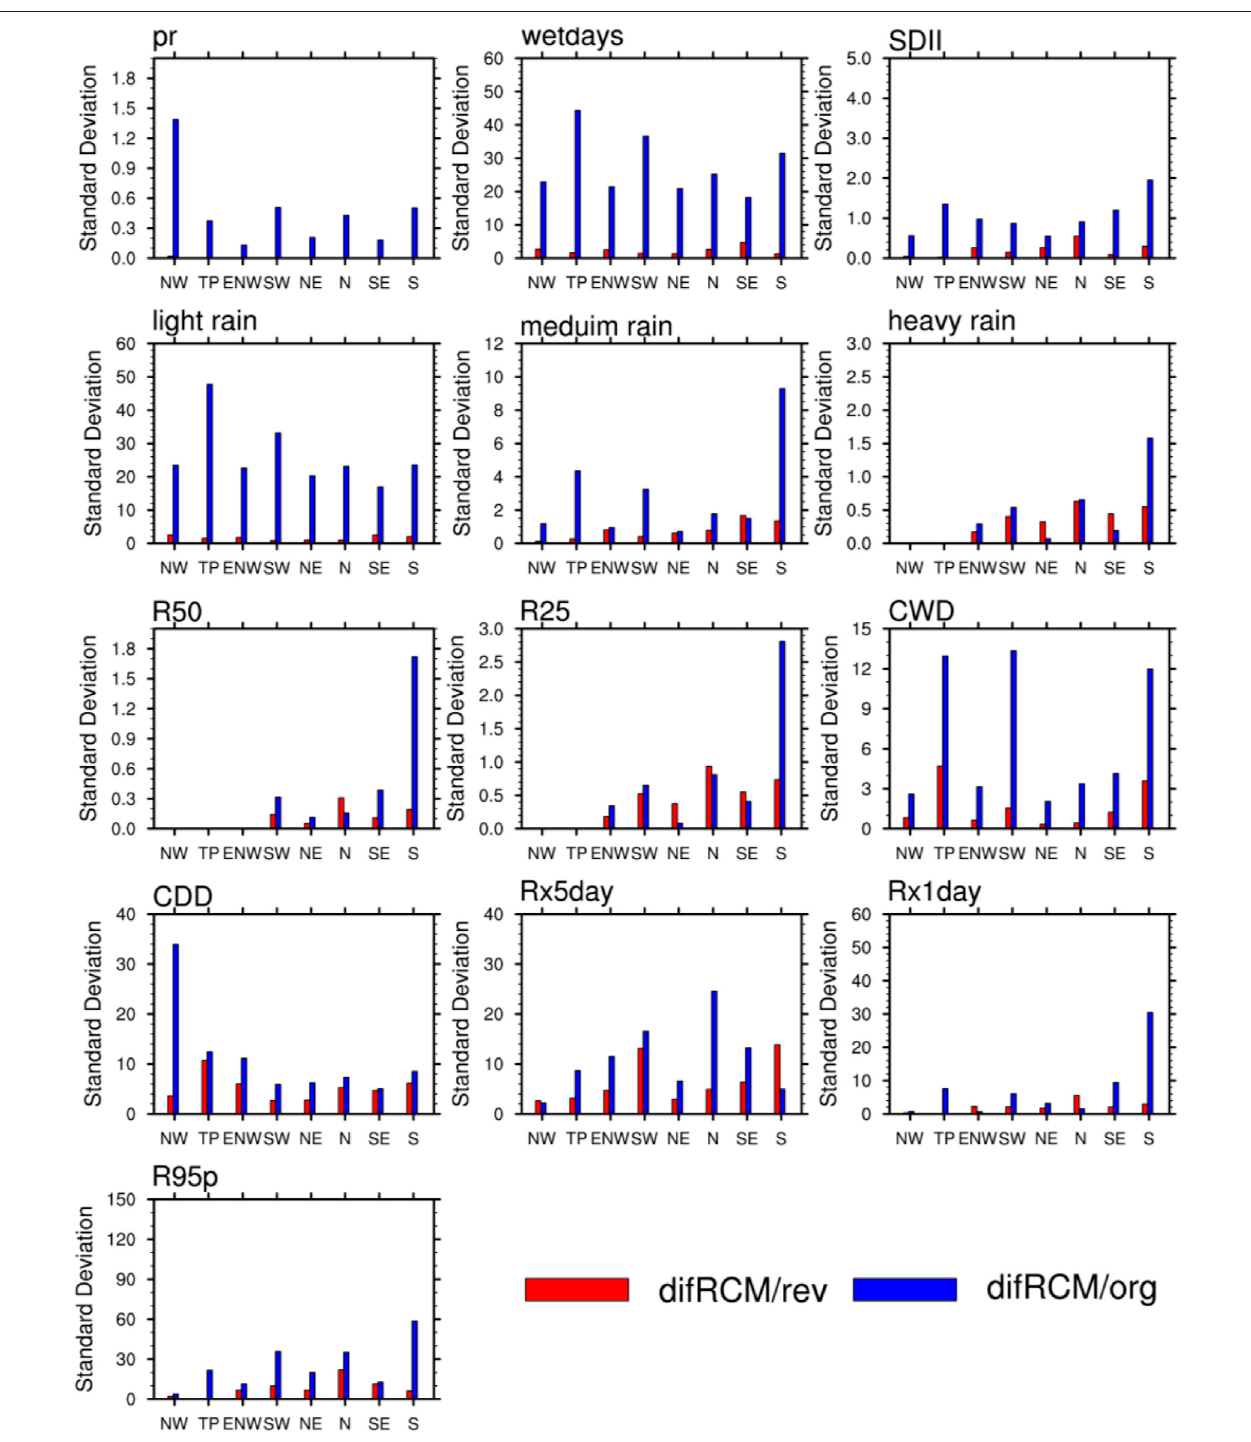
FIGURE9| Standarddeviations ofextremeprecipitationindexesfrom differentRCMsdrivenbythesameGCM(difRCM) in eightsub-regionsbefore (rev)and after correction (org).